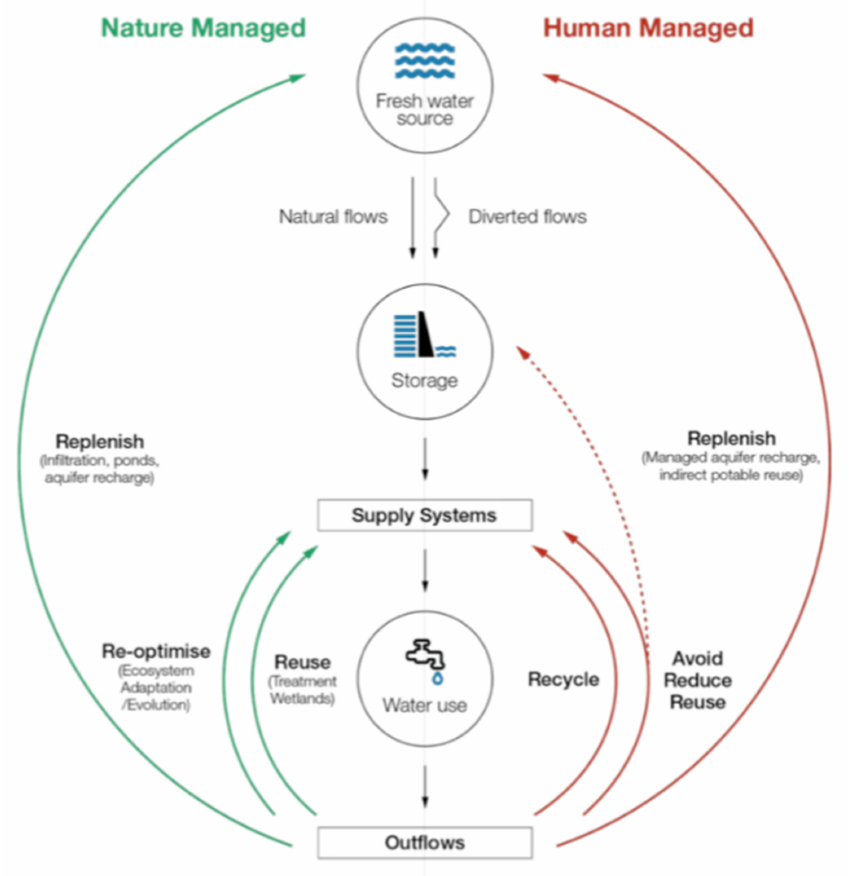
Figure 1. Water in the circular economy